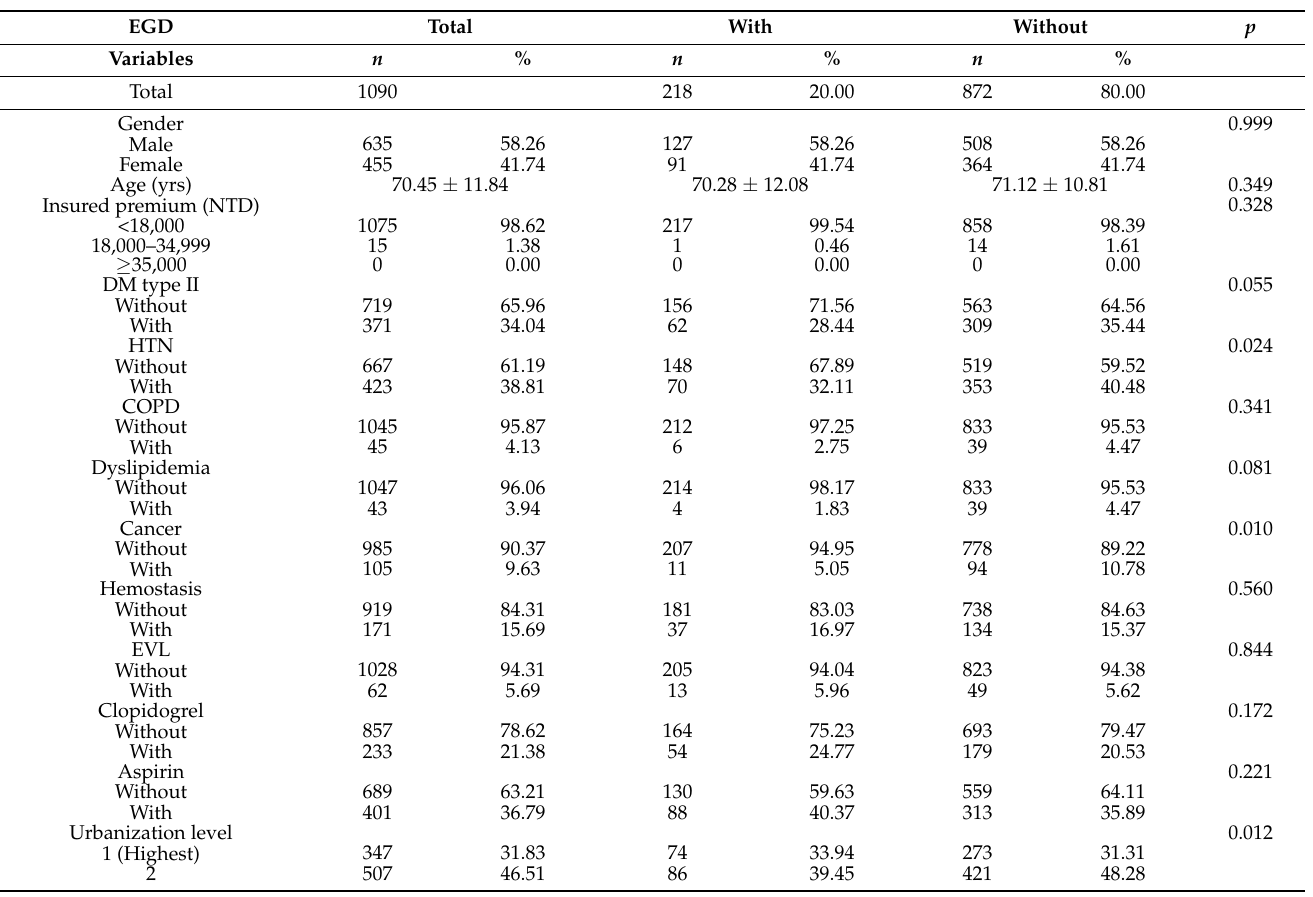
Table 1. Characteristics of